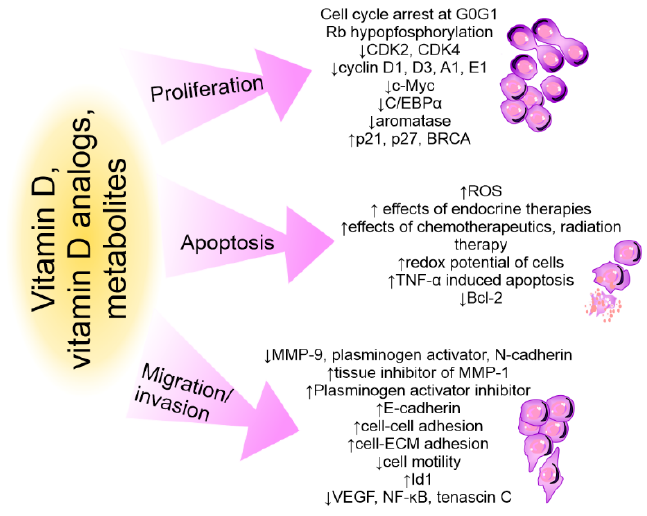
Figure 5. Summary of the mechanisms of vitamin D direct action on breast cancer cells. Rb — reti-